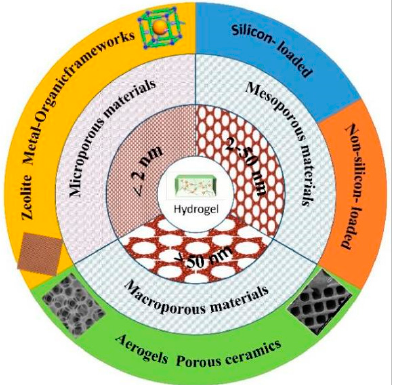
Figure 1. The classification of porous material-loaded composite hydrogels. Table 1. Classification of mesoporous material-loaded composite hydrogels. Hydrogel Properties Reference